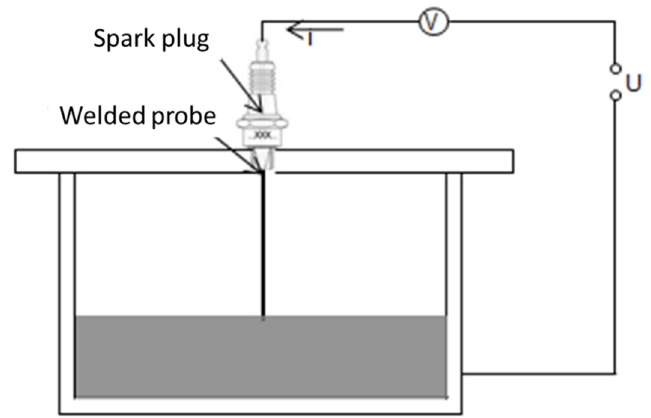
Figure 6. Principle of conductive level detection.